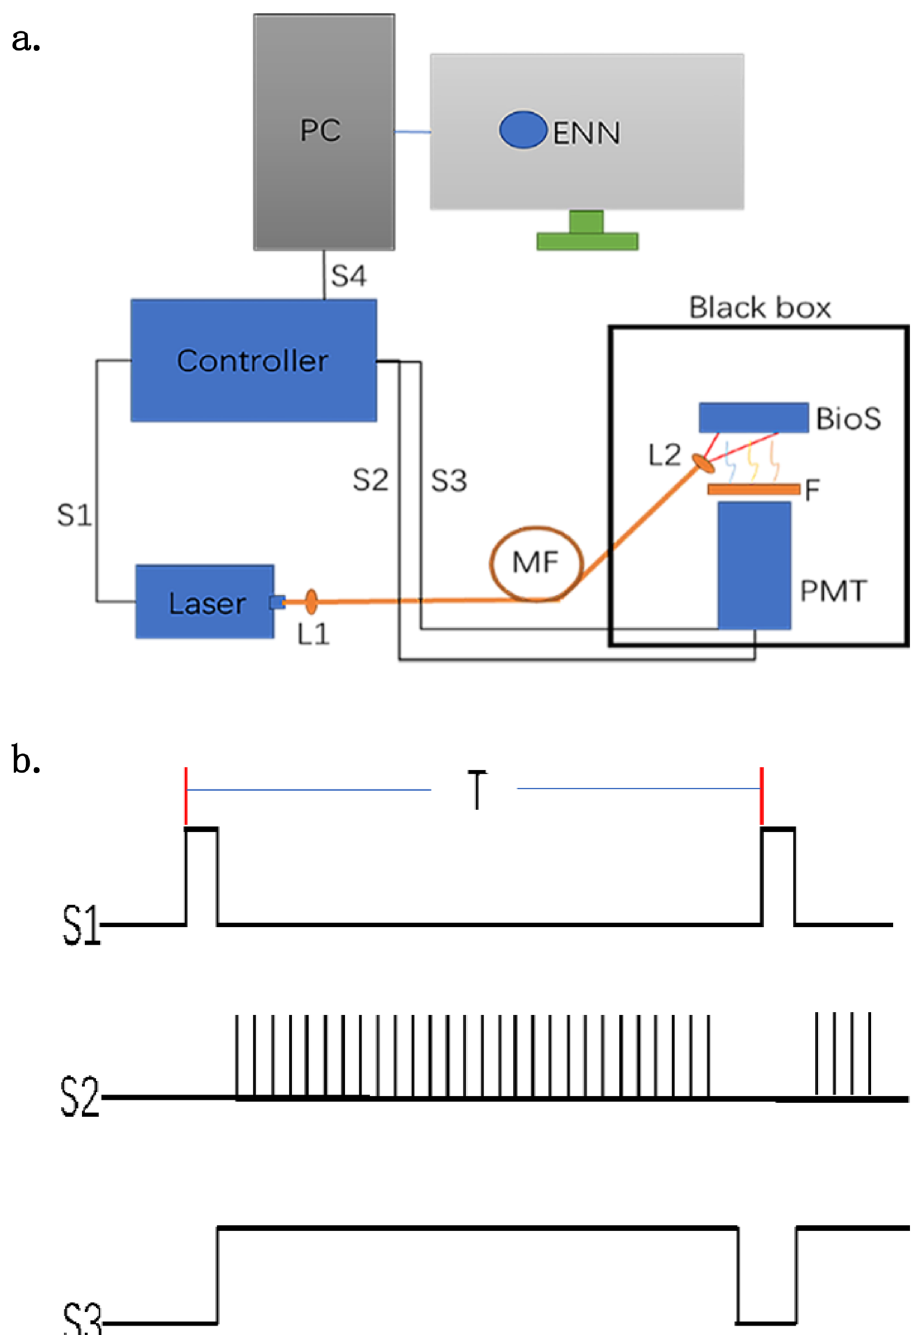
Figure 7. The schematic diagram of delayed luminescence system. MF Multimode optical fiber, PMT Photomultiplier tube, BioS Biological sample, L1/L2 Lens, F Filter, S1 Laser switching pulse, S2 PMT photon counting signal, S3 PMT high voltage control pulse, S4 USB